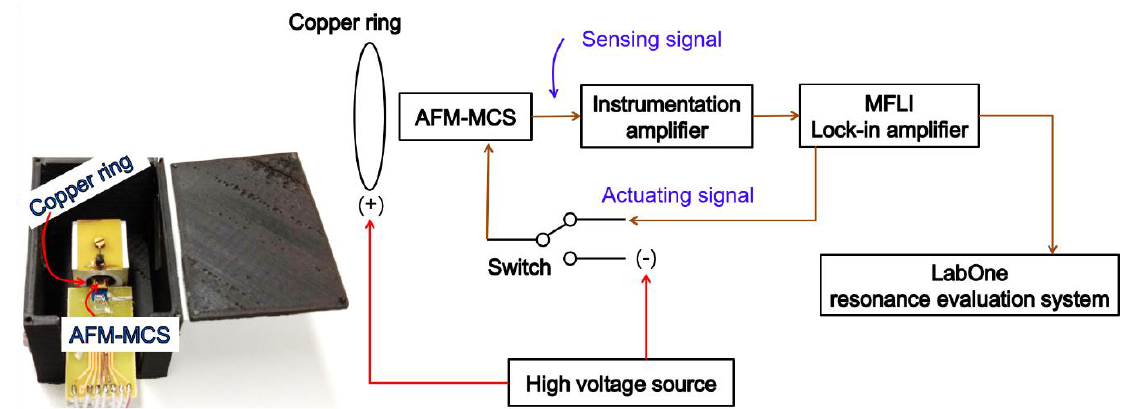
Figure 6. Setup to measure the AFM-MCS signal output using an MFLI instrument (Zurich Instruments AG, Switzerland) interfaced with its default software (LabOne) for observing the cantilever’s resonance frequency by frequency sweeping. A high voltage is applied to the cantilever for nanoparticle trapping by electro-/dielectrophoresis. A manual switch is used to cycle between connecting the cantilever with the actuating signal from a lock-in amplifier and with a high-voltage source for particle collection. During particle measurements, the protection-box cover was opened, as shown in the photograph.